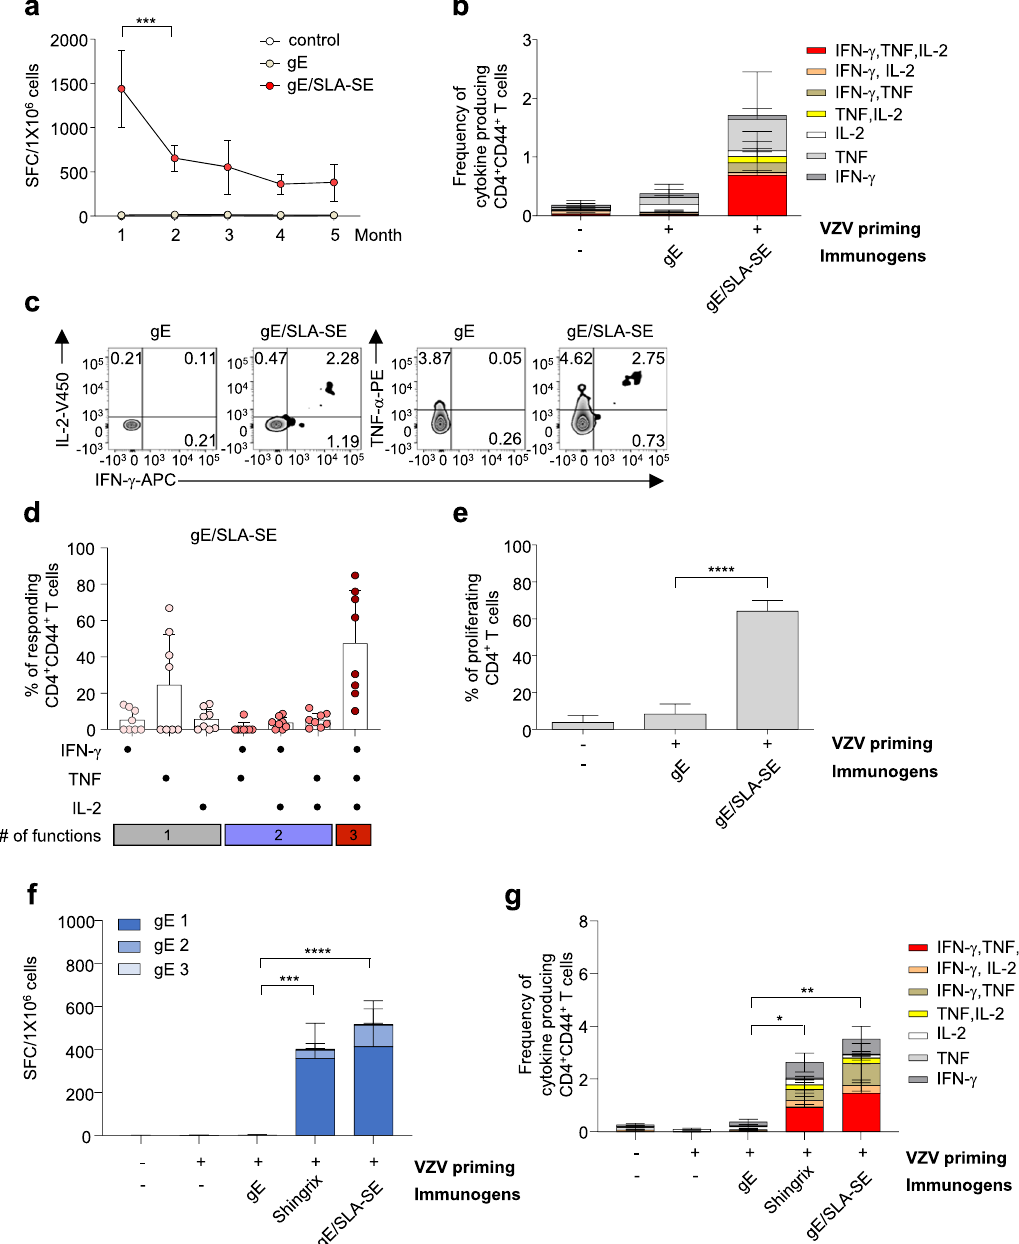
Fig. 4 The durability and functionality of gE-speci fi c T-cell responses by immunization of gE/SLA-SE. Six-week-old mice were primed and immunized twice with either gE (5 µg) or gE (5 µg)/SLA-SE (10 µg SLA in 2% oil) at a 4-week interval. a Detection of gE-speci fi c IFN- γ -secreting T-cell numbers by mouse IFN- γ ELISPOT assay upon stimulation with three pools of 62 gE OLPs (15-mer, 5-mer overlap): gE 1 (20 peptides), gE 2 (20 peptides), and gE 3 (22 peptides). Mice ( n = 4 (control), 8 (group) per each month) were sacri fi ced each month from 1 to 5 months after the second immunization to examine the durability of the antigen-speci fi c T-cell responses. b Measurement of the frequency of cytokine- secreting T cells among CD4 + CD44 hi T cells by intracellular cytokine assay upon gE OLP stimulation 5 months after the second immunization. c Representative FACS plots of IFN- γ , TNF, and/or IL-2-secreting CD4 + CD44 + T-cell populations 5 months after the second immunization in gE or gE/SLA-SE immunized mice. d CD4 + T-cell polyfunctionality analyzed by every possible combination of functions using Boolean analysis in spleen cells from gE/SLA-SE immunized mice 5 months after the second immunization upon gE OLP stimulation. e The percentage of proliferating gE-speci fi c CD4 + T cells using Violet Proliferation Dye 450 in spleen cells from either gE or gE/SLA-SE immunized mice 5 months after the second immunization upon 6-day stimulation with gE OLP. f , g Comparison of the durability and functionality of gE-speci fi c T-cell responses induced by gE/SLA-SE or Shingrix. Six-week-old mice were primed and immunized twice with gE (5 µg), gE (5 µg)/SLA-SE (10 µg SLA in 2% oil), or Shingrix (1/10 human dose, gE [5 µg]/AS01 B [5 µg MPL and 5 µg QS21]). Three months after the second immunization, spleen cells were prepared to examine cell-mediated immunity. f Detection of gE-speci fi c IFN- γ -secreting T-cell numbers by mouse IFN- γ ELISPOT assay using spleen cells from immunized mice upon ex vivo stimulation with three pools of 62 gE OLPs (15-mer, 5-mer overlap): gE 1 (20 peptides), gE 2 (20 peptides), and gE 3 (22 peptides). g CD4 + T-cell polyfunctionality analyzed by every possible combination of functions using Boolean analysis in spleen cells from immunized mice upon ex vivo gE OLP stimulation. Data are representative of two independent experiments, and data are presented as means and standard deviations. *** P < 0.005, **** P < 0.001 (ordinary one-way